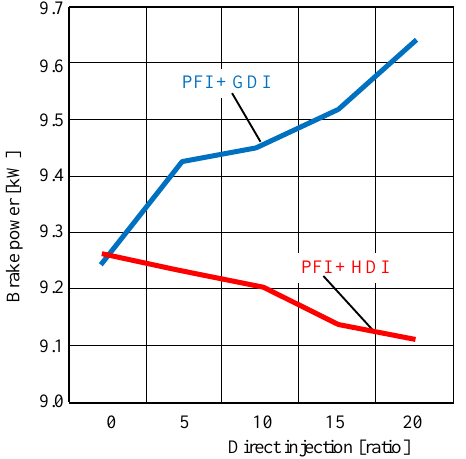
Fig. 5. The change in engine power output as a result of different dual fuel engine supply methods